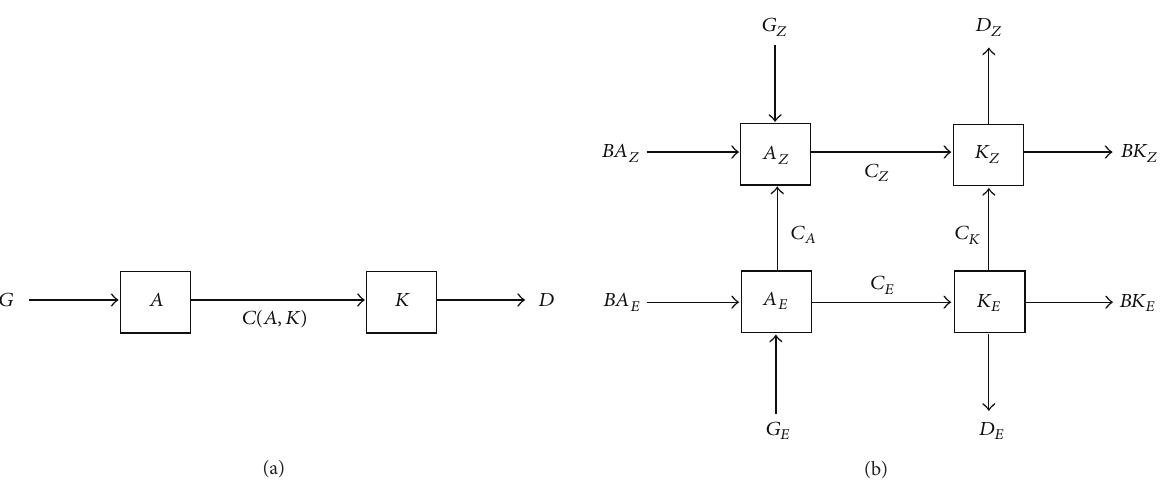
Figure 1: Lorenz energy cycle representation for (a) two-component energy cycle in which available potential energy denoted by the letter 𝐴 is generated (𝐺) , converted (𝐶) to kinetic energy (𝐾) , and subsequently dissipated (𝐷) . (b) Four-component energy cycle with 𝐴 and 𝐾 decomposed into mean and eddy parts. Adapted from